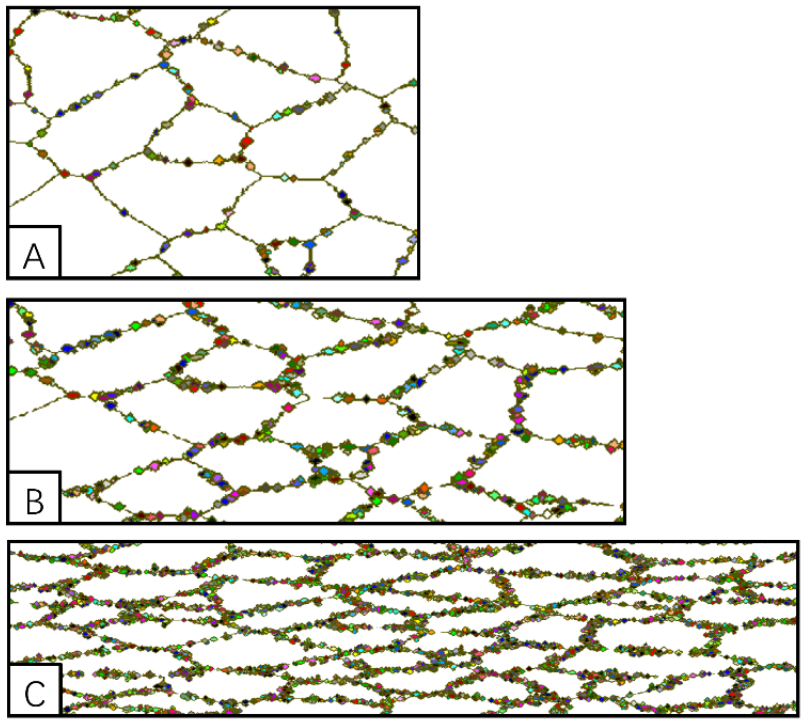
Figure 13. Grain deformation diagram during CA simulation at Different stages ( A ) dynamic recrystallization nucleation initial stage ( B ) grain shape change stage ( C ) final stage.